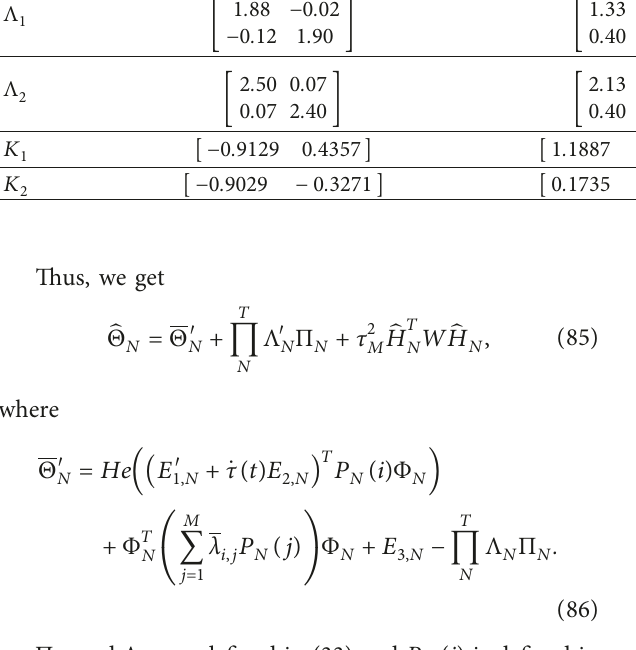
Table 1: The controller gains K